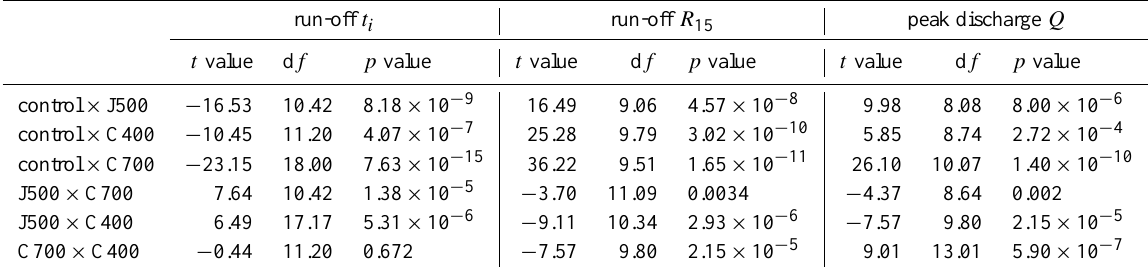
Table 6. Parameters ( t value, degree of freedom d f and p value) of the Welch two-sample t test; significance level 0.05.